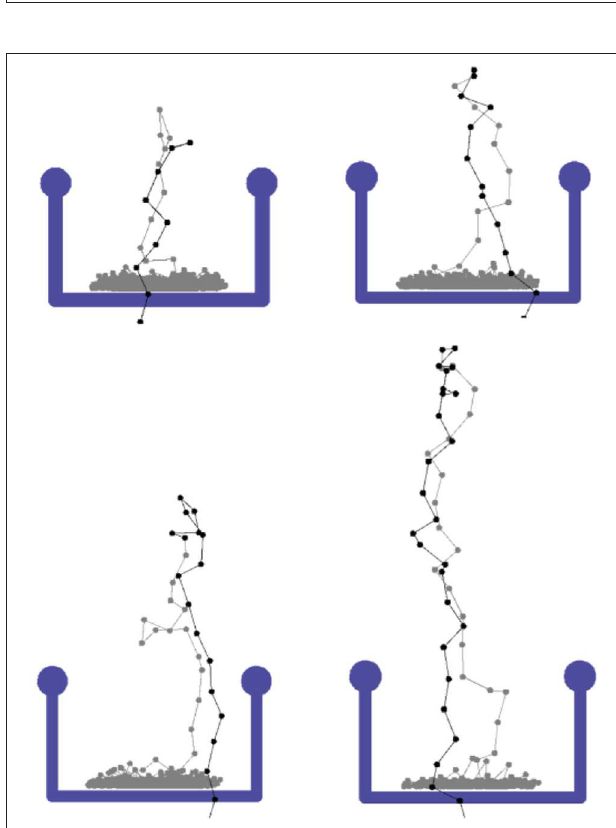
FIGURE 9 | A simulated time sequence of the fountain evolution using the separated beads model.